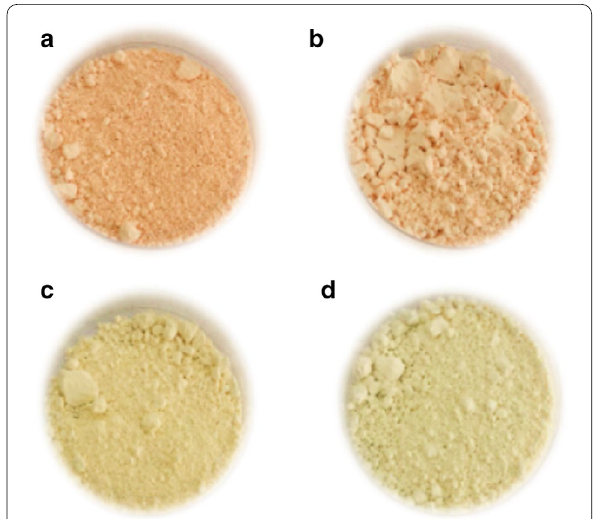
Fig. 1 Carotenoid microcapsules of mamey and carrot in a mixture of maltodextrin (10% w/v) and Arabic gum (5 or 10% w/v) as